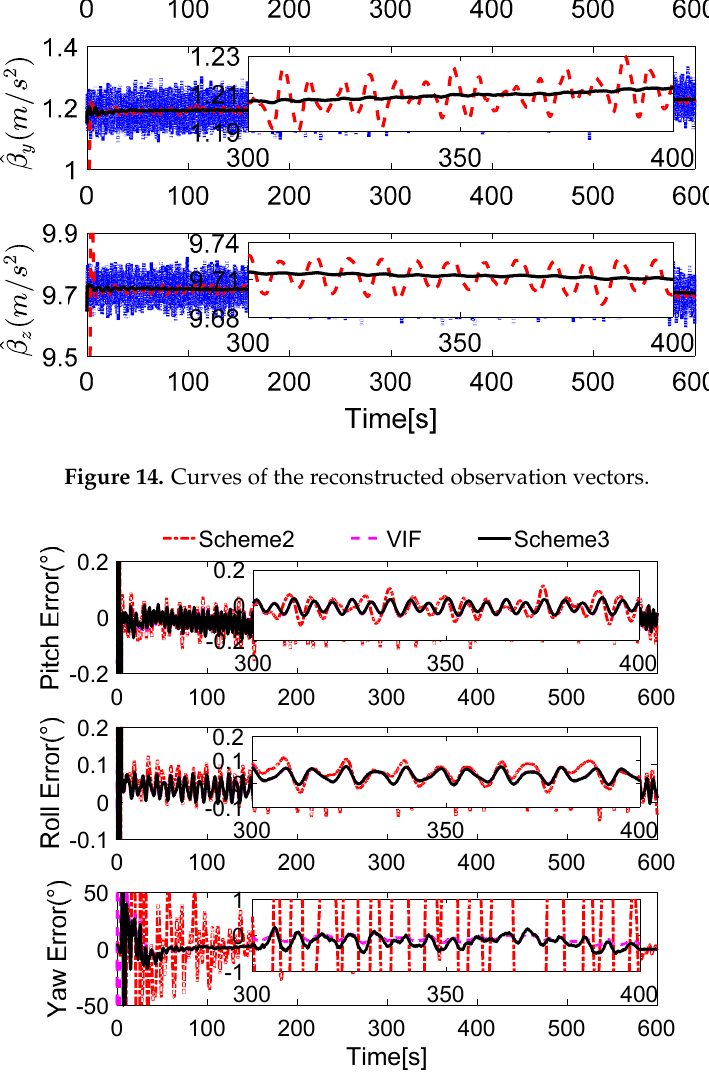
Figure 15. Curves of alignment errors.